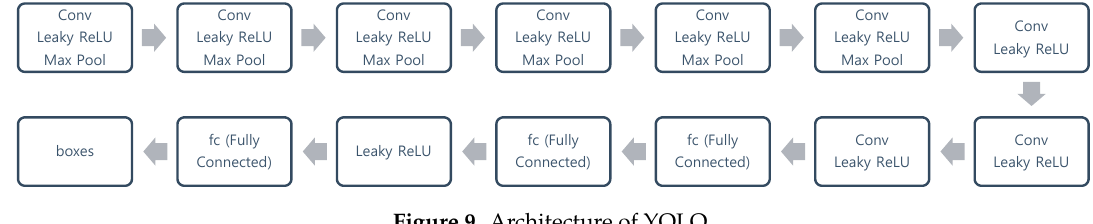
Figure 9. Architecture of YOLO.